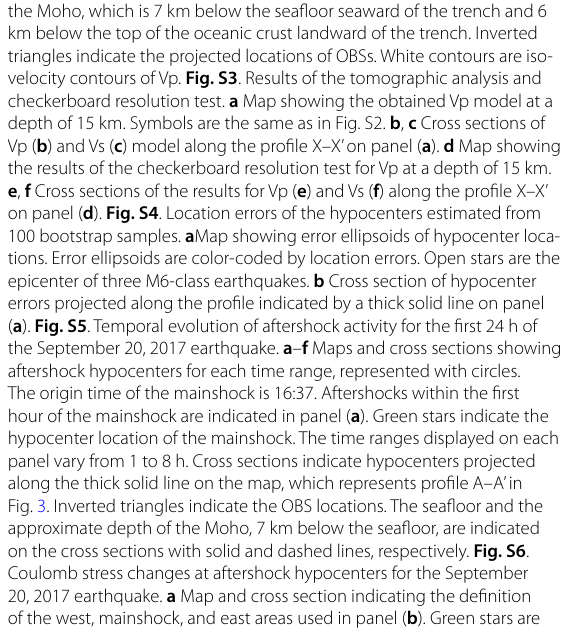
Fig. 10 Hypocenter distribution and bathymetry relief along the Japan Trench. a Hypocenter distribution obtained in this study and previous studies (Obana et al. 2018, 2019, 2021), represented by colored circles. The thick dashed line indicates the Japan Trench axis. Yellow and blue shaded areas indicate the coseismic (Iinuma et al. 2012) and postseismic (Iinuma et al. 2016) slip areas of the 2011 Tohoku-oki earthquake, respectively. Contours for 5-, 20-, and 50-m coseismic slip and 0.4- and 0.8-m postseismic slip are indicated. The pink rectangle and arrows indicate the slow slip event in 2015 and horizontal displacement rates relative to the North American Plate, respectively (Honsho et al. 2019). The thick solid line rectangle indicates the area shown in panels ( b ) and ( c ). b Red relief bathymetry map (Chiba et al. 2008) showing epicenter distribution. Green circles represent the epicenters of earthquakes shallower than 14 km obtained in this study and previous studies (Obana et al. 2018, 2019, 2021). Arrows and white dashed rectangles indicate linear earthquake trends identified in previous studies in the northern and southern sections of the Japan Trench (Obana et al. 2018, 2021). The dashed white line indicates the Japan Trench axis. c Red relief bathymetry map without the